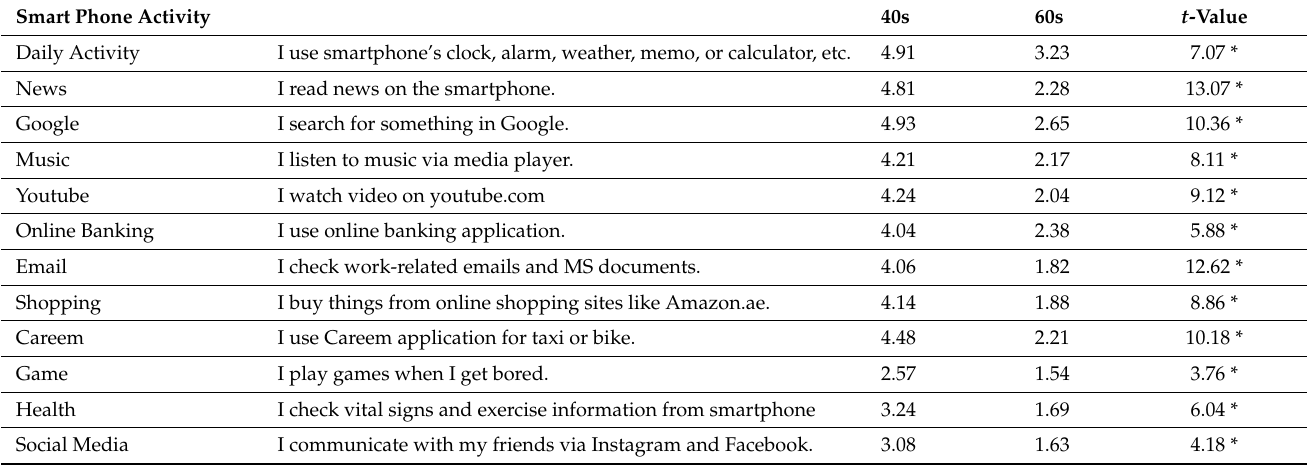
Table 4. Smartphone Usage by Age Group (* p <